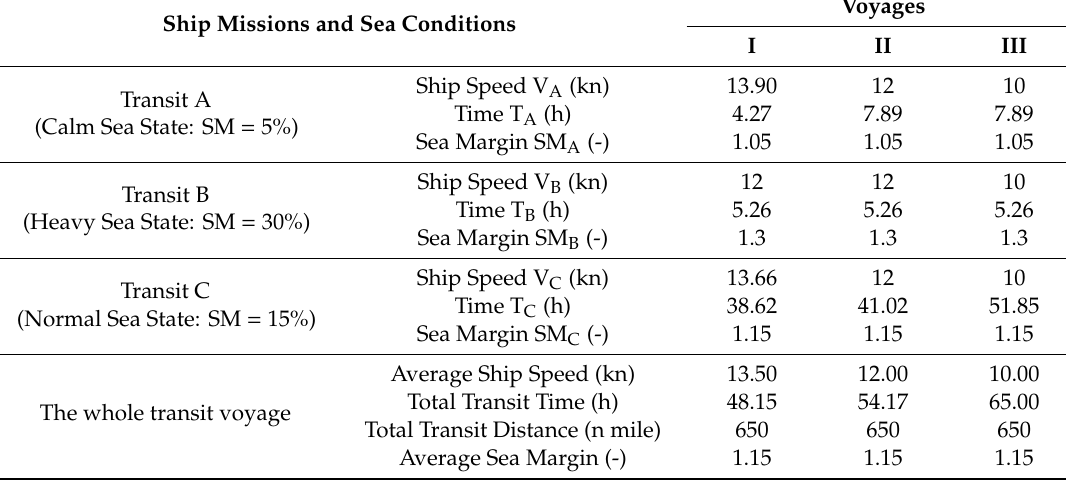
Table 4. Ship mission profiles when sailing in open